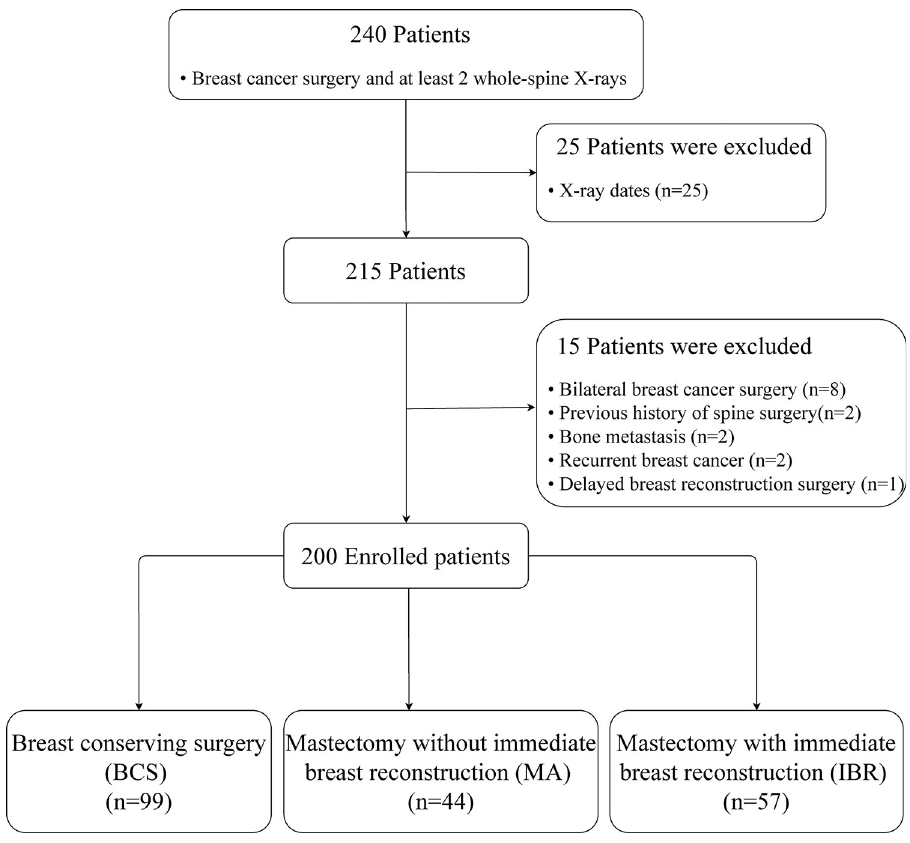
Fig 1. Flow diagram depicting the study’s patient selection